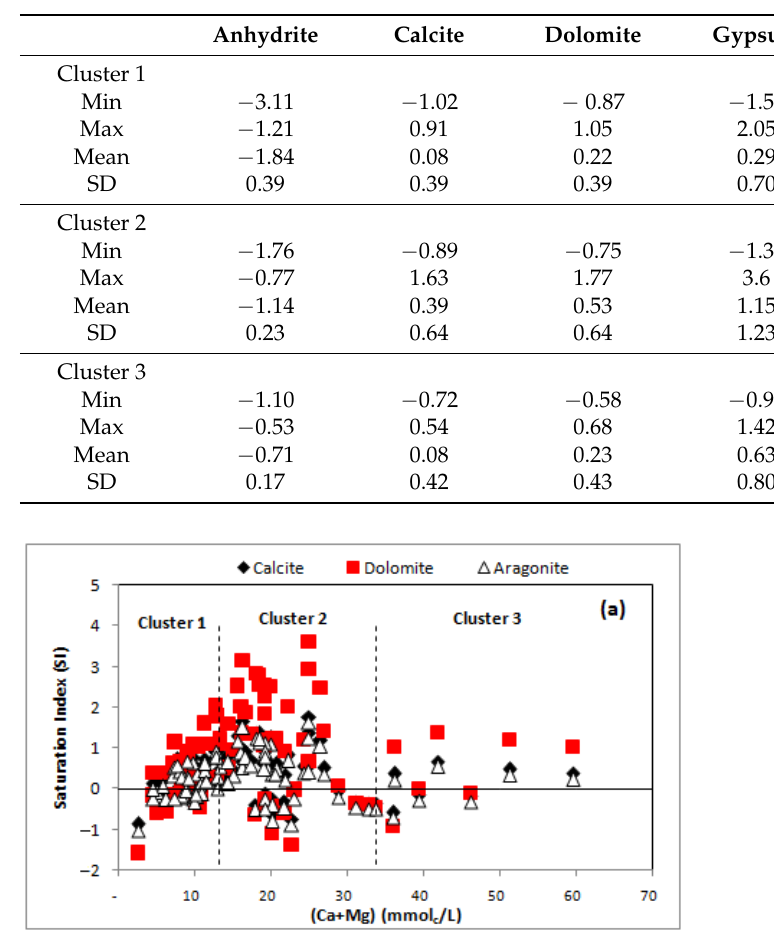
Table 3. Summary of minerals Saturation Index ( SI ) in groundwater using PHREEQC.